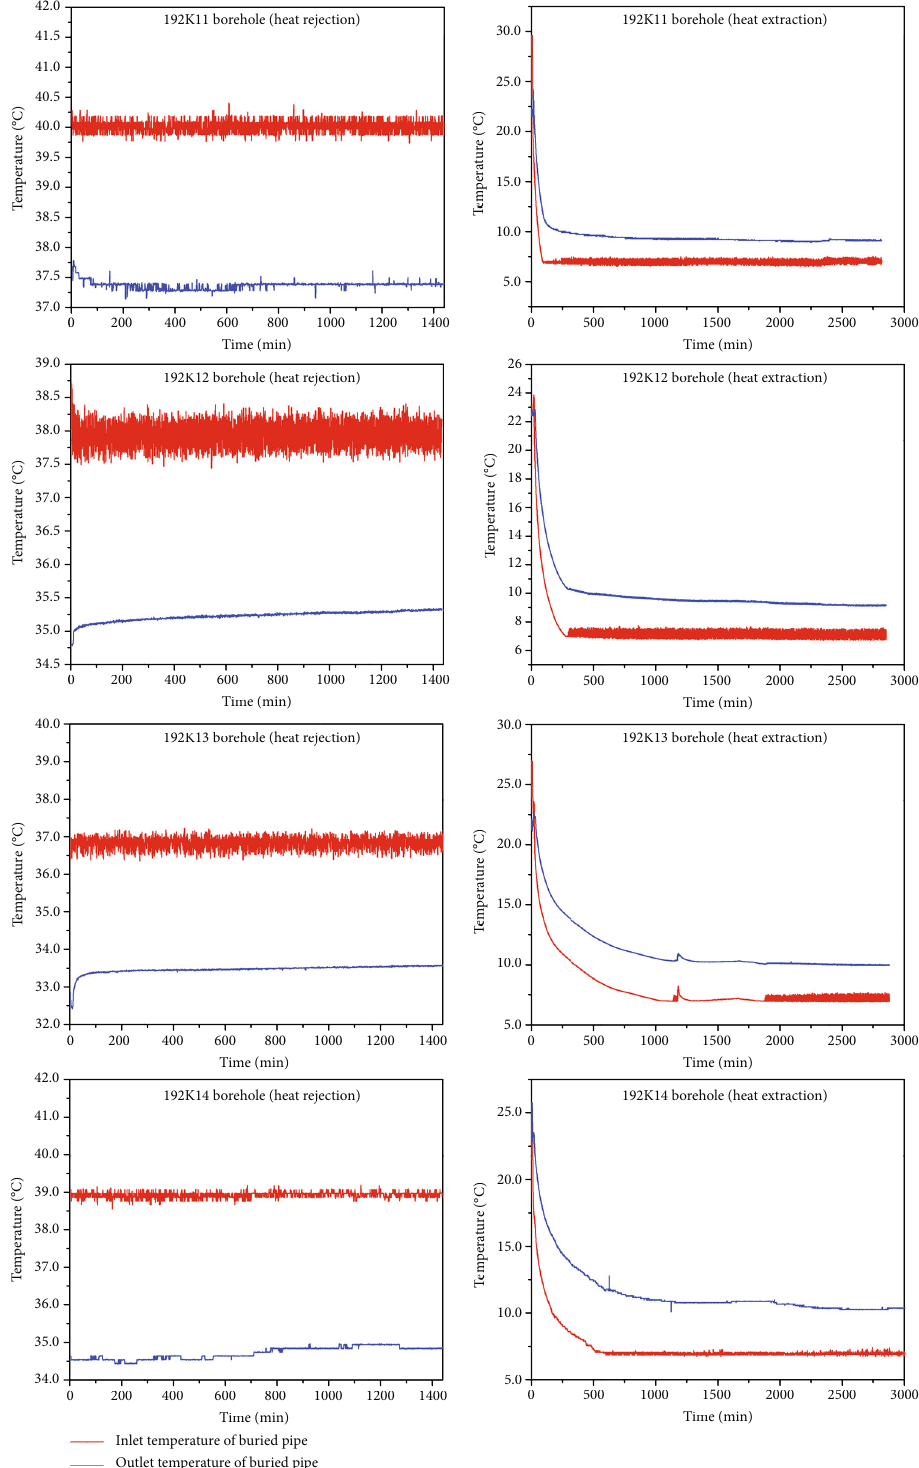
Figure 12: The variation of temperature with time of four geothermal holes under Case 4 and Case